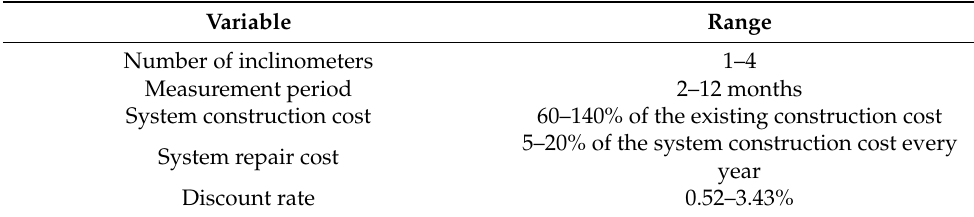
Table 11. Ranges of the variables subjected to sensitivity analysis.